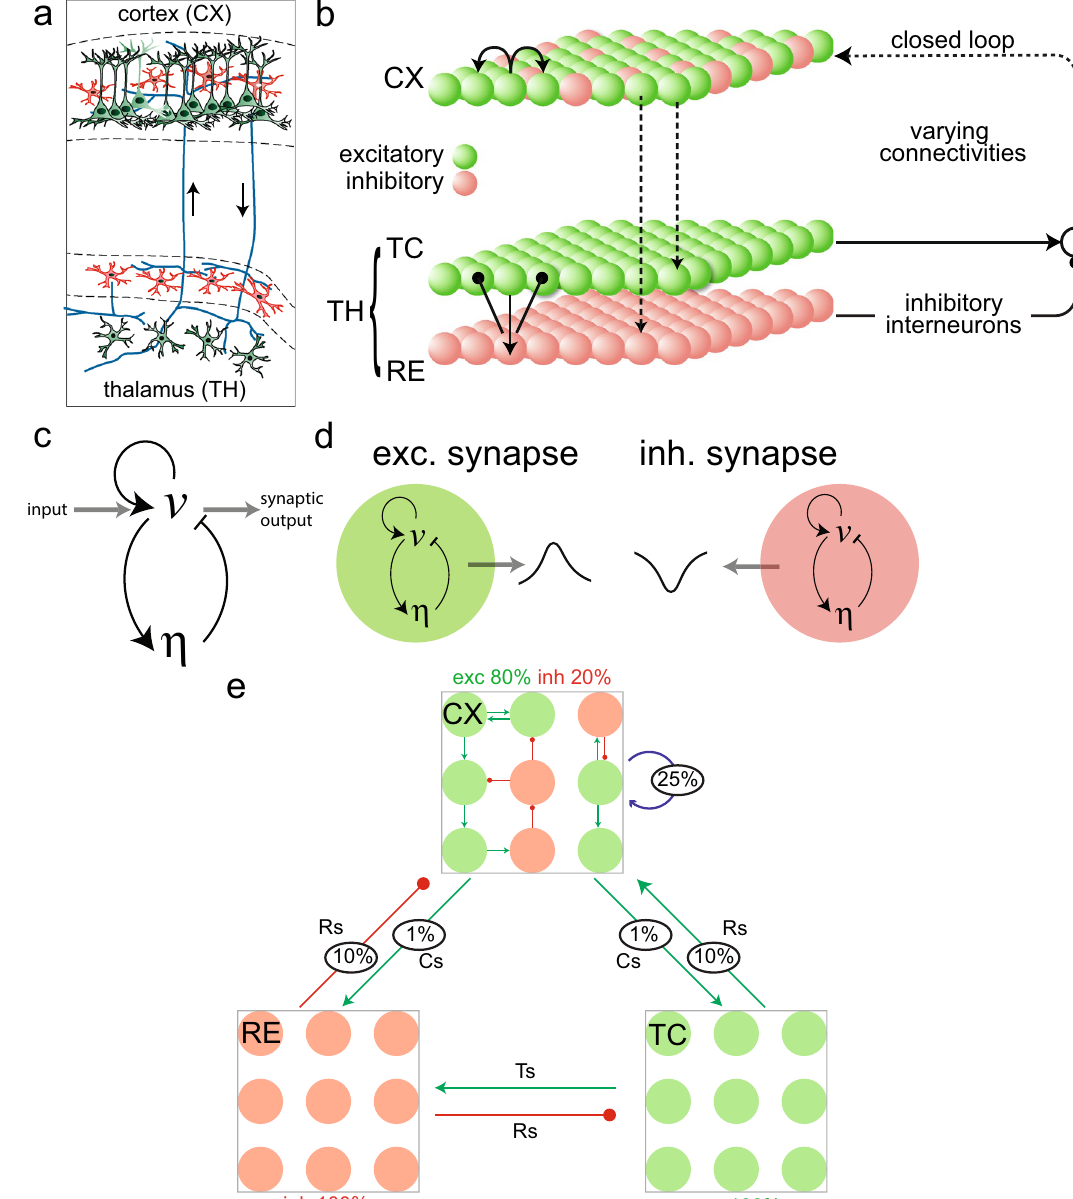
Figure 1. Neuron model and thalamocortical network structure. ( a ) Diagram of the thalamocortical circuit (adapted by permission from: Destexhe A., Contreras D. The fine structure of slow-wave sleep oscillations: from single neurons to large networks. In: Hutt A. (eds) Sleep and Anesthesia. Springer Series in Computational Neuroscience, vol 15. Springer, New York, NY, copyright (2011) 39 ). ( b ) Two-dimensional (2D) schematic representation of the computational model with a three-layer architecture: CX (cortex, containing both excitatory and inhibitory cells, size: 60 60), RE (inhibitory thalamic reticular nuclei cells, size:60 60) and × × TC (excitatory thalamocortical relay cells, size: 60 60). RE-TC are reciprocally connected. The network is × connected in a closed loop. ( c ) The excitable neuron module, showing the self-enhancing voltage term ( v ) with negative feedback from the gating variable ( η ), and the input-output scheme ( d ) Schematic showing how each module can be excitatory (green) or inhibitory (red) depending on the type of synaptic output. ( e ) Graphical illustration of thalamocortical network connections, with green indicating excitatory (exc), red indicating inhibitory (inh), and blue indicating mixed excitatory and inhibitory connections, respectively. T s , R s , and C s represent the synapses for the TC, RE, and CX layers, respectively. The number inside the circle represents the connectivity percentage used in the normal operating